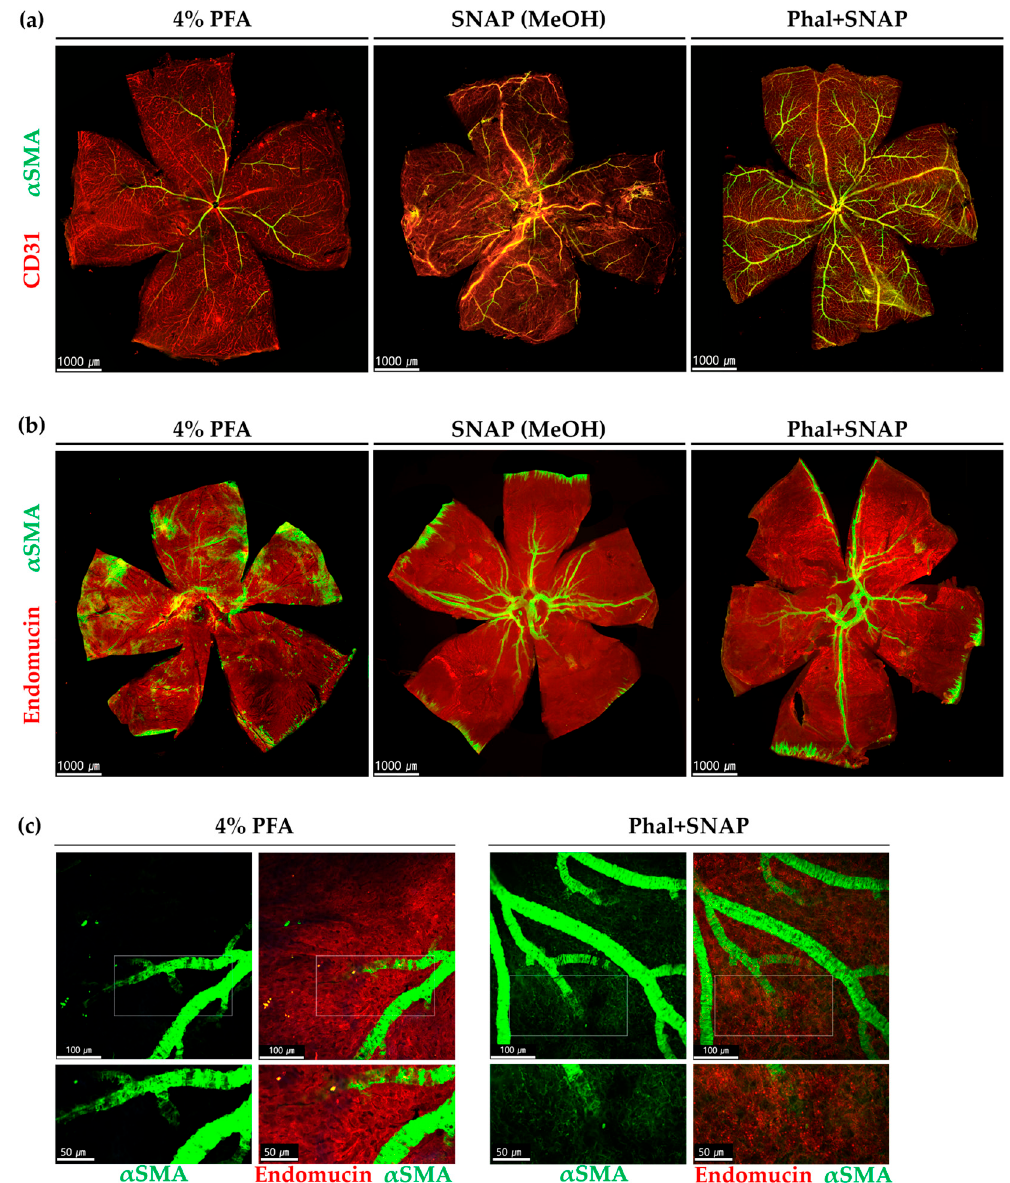
Figure 1. α SMA expression in retinas ( a ) and choroids ( b , c ). PFA fixation, snap fixation, and snap